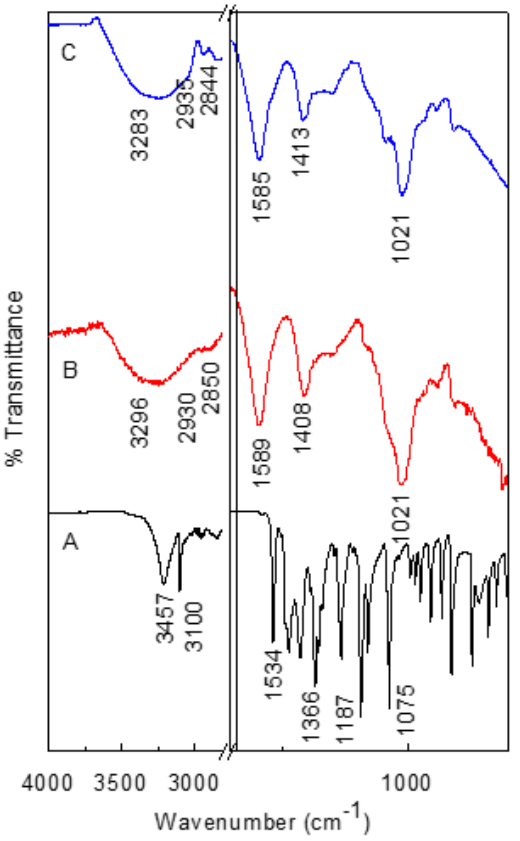
Figure 11. FTIR spectra of MET ( A ), CS-AlgNPs ( B ) and MET-CS-AlgNPs ( C ).